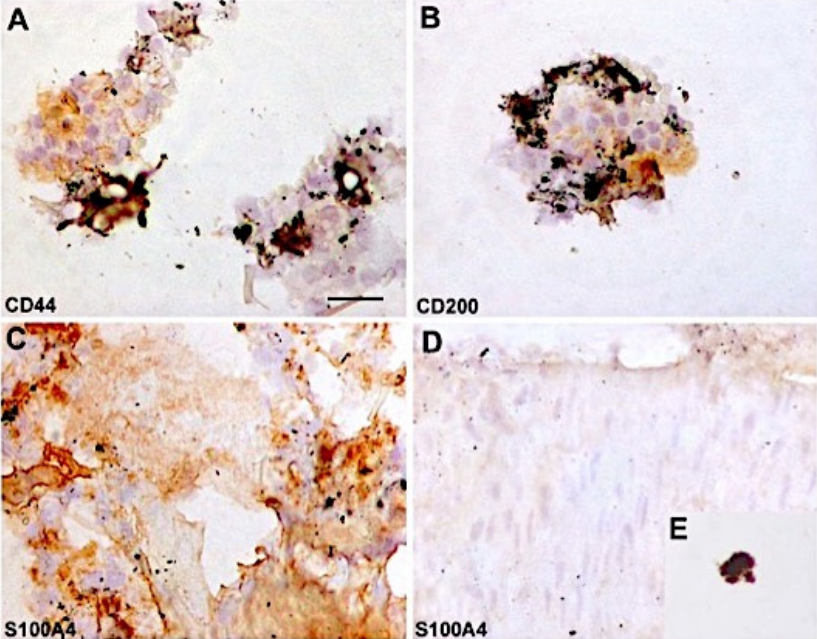
Figure 4. Immunophenotypic characterization of micro-graft’s suspension containing HD-AFSCs. ( A , B ) Immunocytochemistry for mesenchymal and epithelial stem cells markers, CD44 and CD200, respectively. ( C ) The positive expression of S100A4 in dermal fibroblasts. ( D ) The immunonegativity of epithelial cells. ( E ) Some melanocytes are shown in detail. Scale Bars 50 μ m. Magnification 40×.